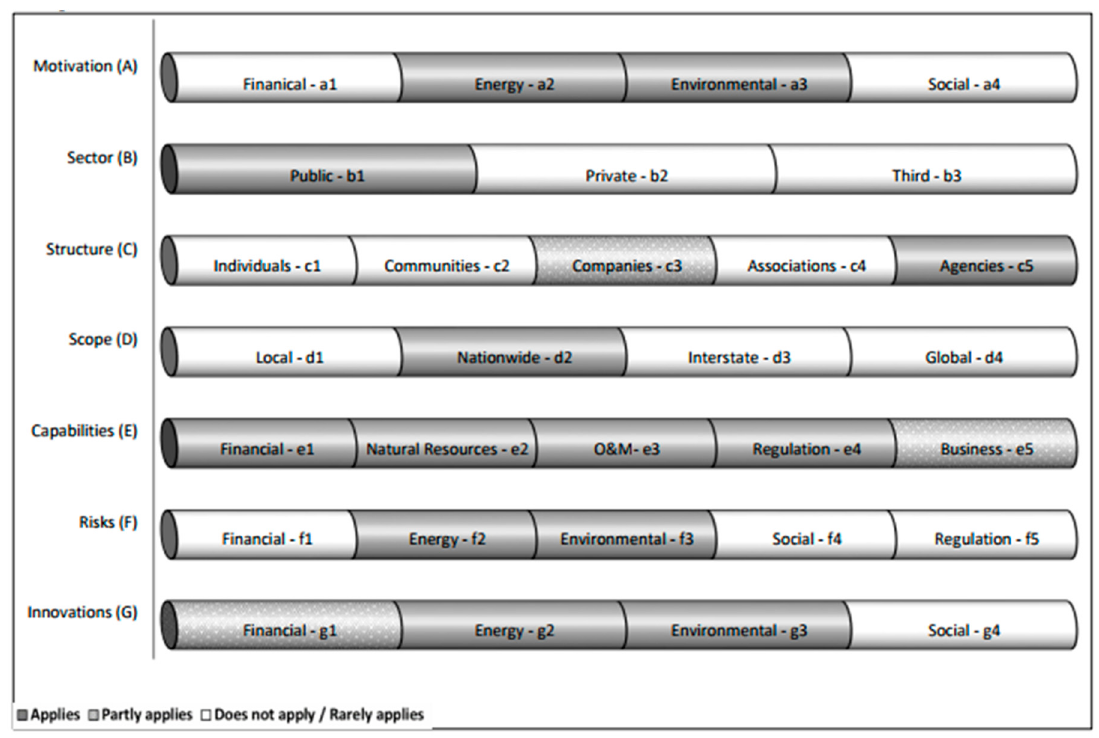
Figure 3. Schematic profile of the State Grid Corporation of China.